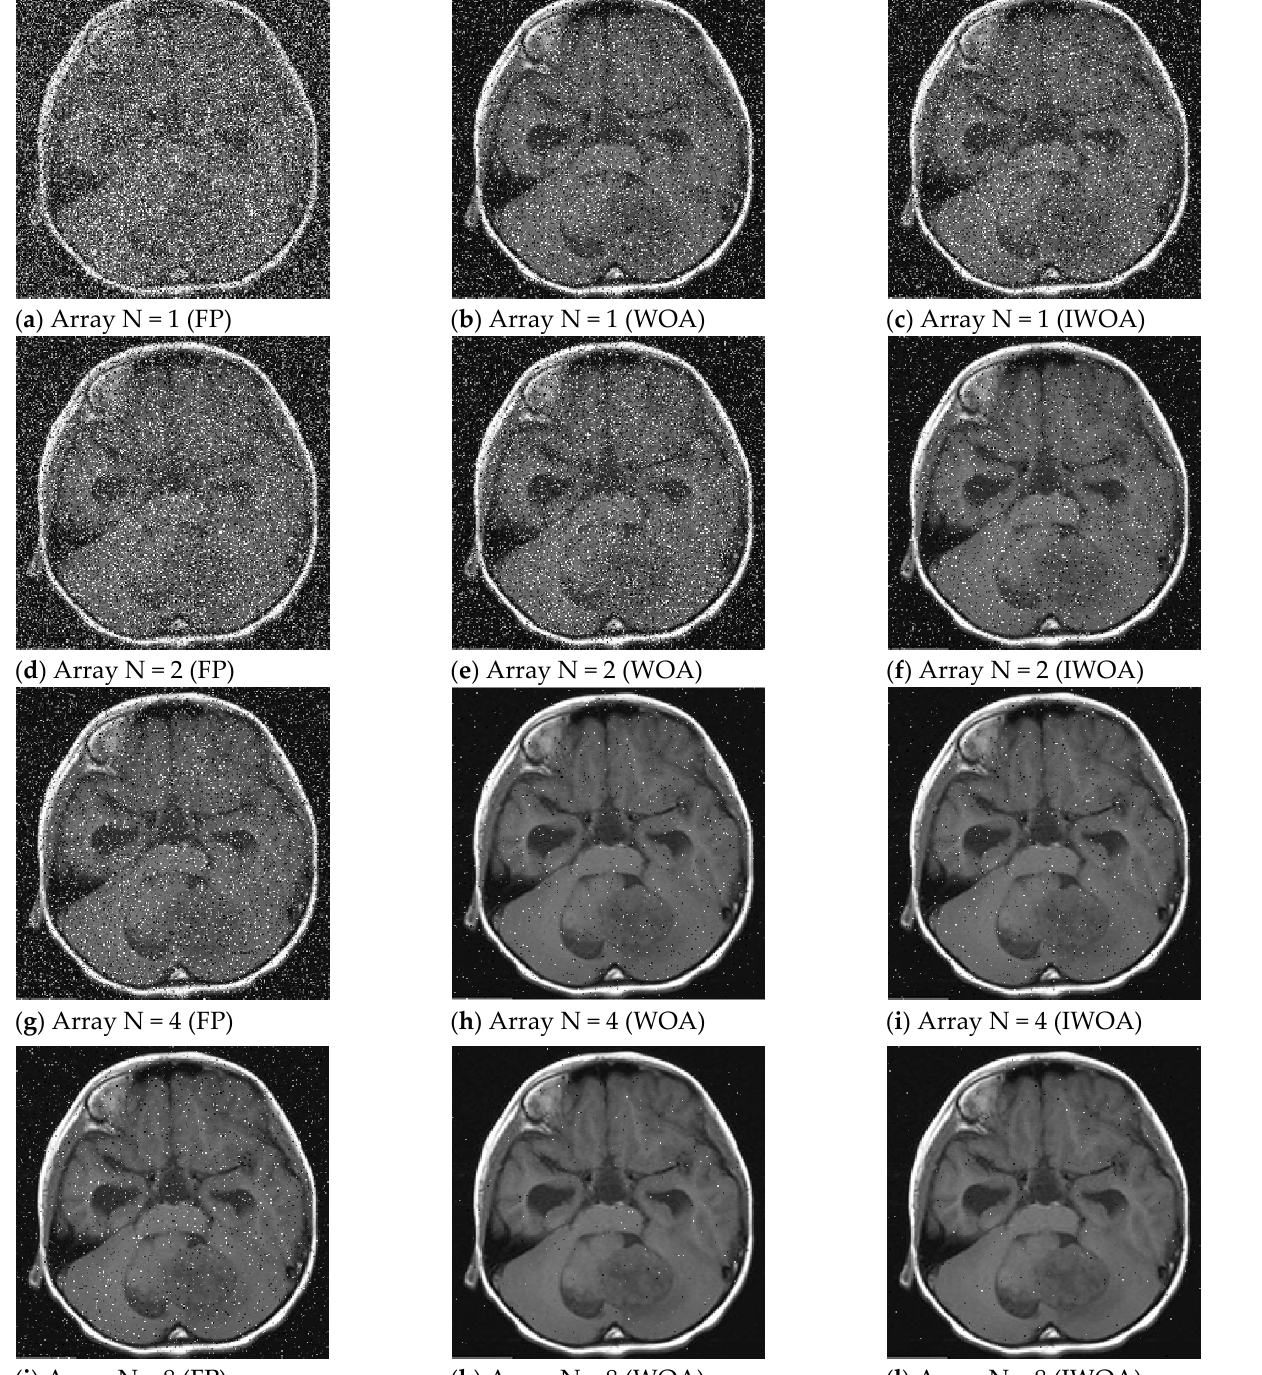
Figure 9. Comparison of denoising effect of MRI image.